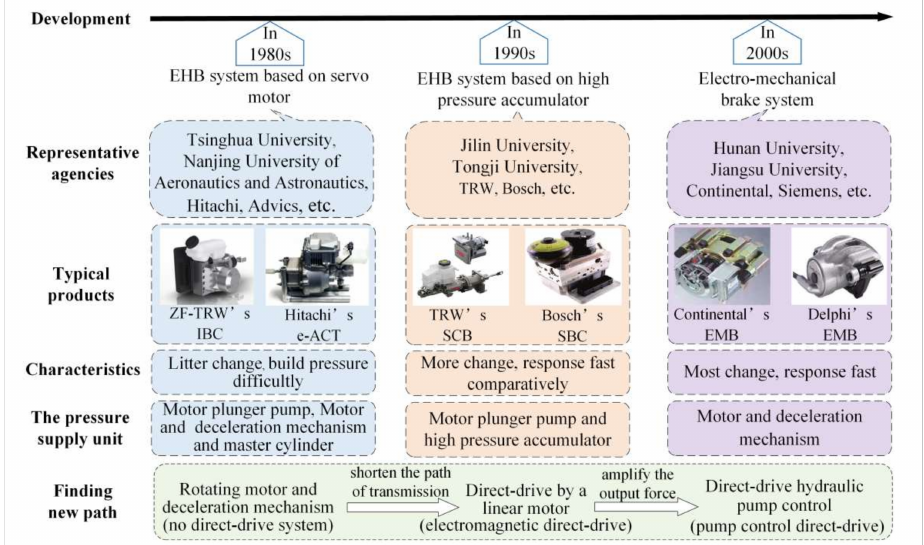
Figure 1. Structures and characteristics of a typical BBW system